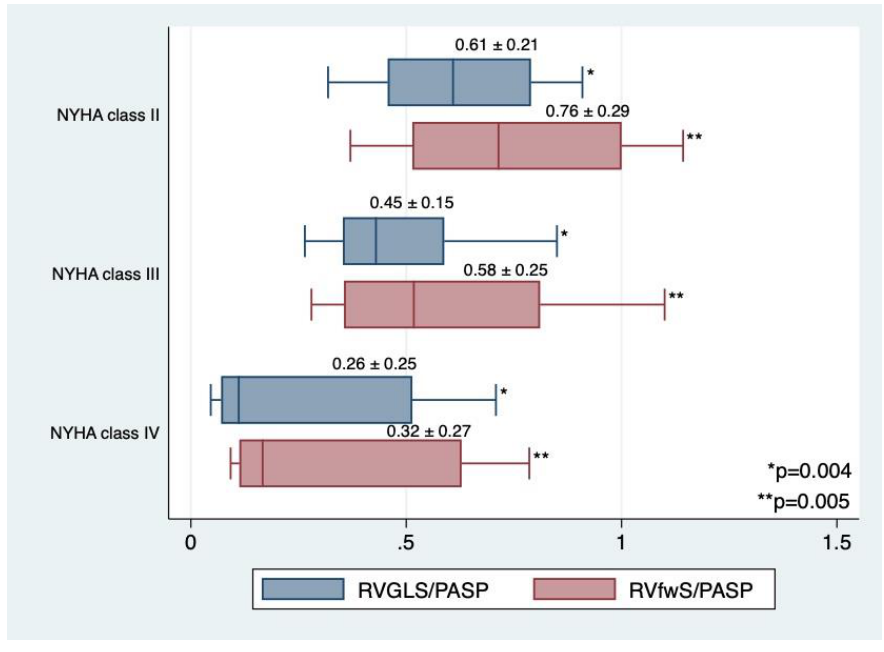
Figure 2. Mean values of RVGLS/PASP and RVfwS/PASP among NYHA classes at baseline. Lower values of RVGLS/PASP are associated with high values of E/e ratio (r = −0.46, p = 0.02).